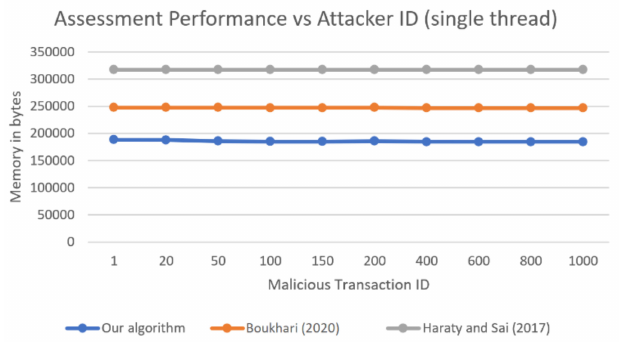
Figure 7. Comparison of the total memory used by three single-threaded algorithms as a function of the malicious transaction ID.